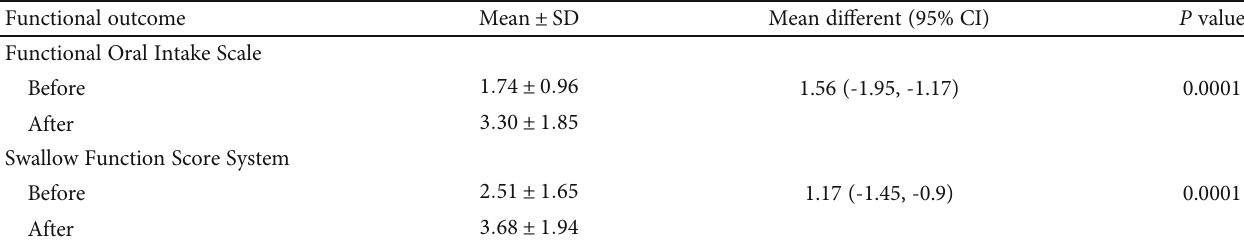
Table 2: Comparison of functional outcome before and after swallowing therapy. Functional